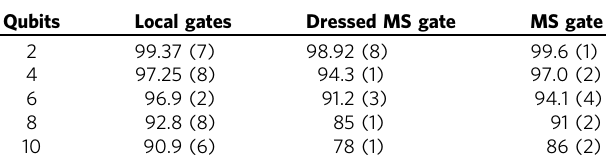
Table 1 Process fi delities (%) estimated via CB. Measured fi delities for local gates, dressed MS gates, and the inferred MS gate fi delity as depicted in Fig.